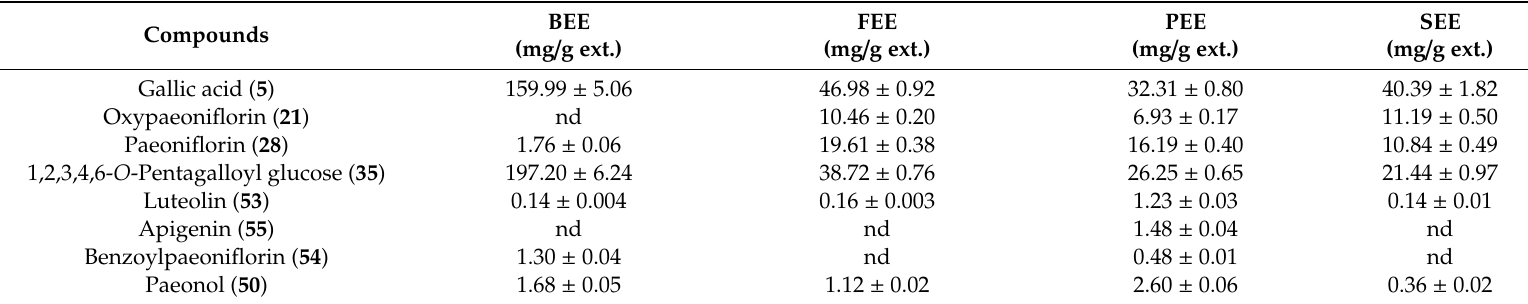
Table 4. Contents of three phenols, three monoterpenoids, and two flavonoids in the bud, flower, petal, and stamen ethanolic extracts of Paeonia su ff ruticosa flowers, as determined using HPLC-DAD